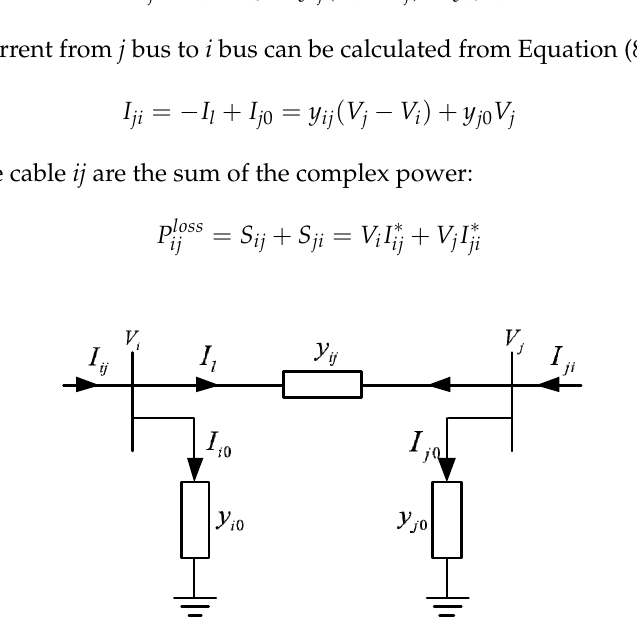
Figure 3. Schematic of collector cables.